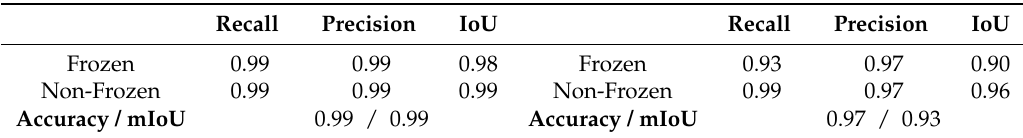
Table 8. Detailed results on MODIS (left) and VIIRS (right) data for the best cases of 4-fold cross validation on combined data from two winters.